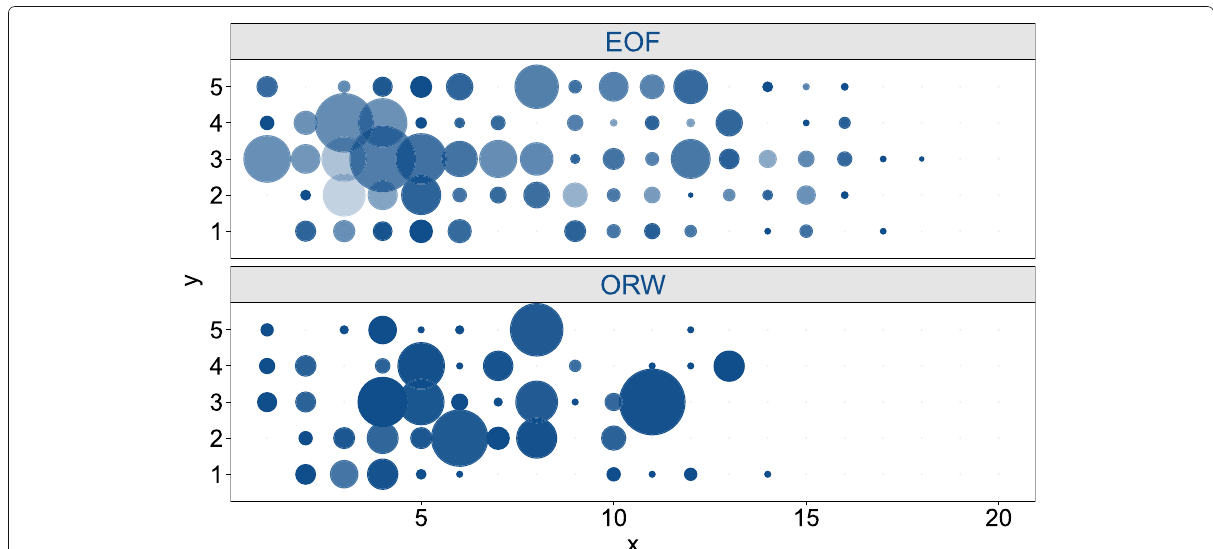
Fig. 5 Per-node throughput against node’s position. Here, the color intensity and the size of bubbles represent the per-node throughput and the count of per-node communicating operations, respectively